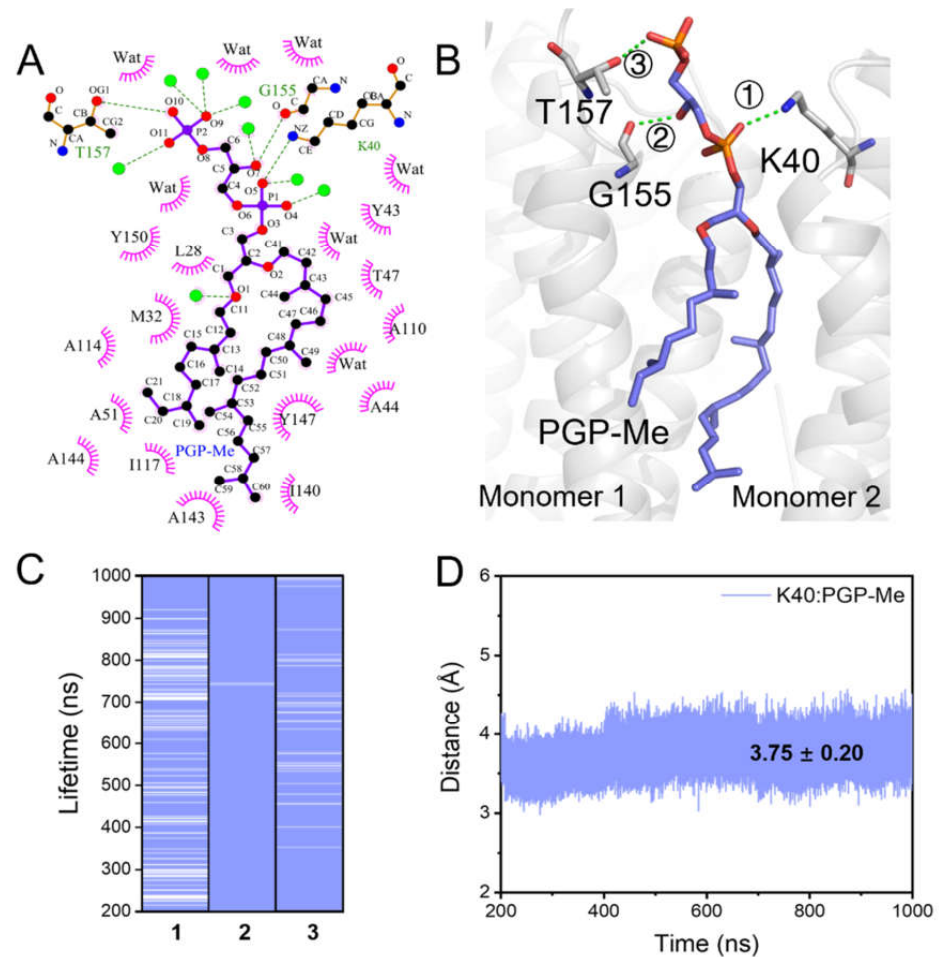
Figure 4. Schematic representation of PGP-Me binding to the bR trimer. ( A ) The LigPlot+ diagrams of the PGP-Me binding sites from the last snapshot of M1; the green dotted lines and the pink spoked arcs represent H-bond and hydrophobic interactions, respectively; ( B ) the possible H-bond interactions (green dotted line) between PGP-Me and the two adjacent monomers in the bR trimer. The grey sticks represent the residues interacting with PGP-Me via H-bond, and the dark-blue sticks represent PGP-Me; ( C ) evaluation of the lifetimes of the H-bond interactions for PGP-Me; see ( B ) for the description of the numbers: (1) K40∙∙∙O5 of the phosphate group; (2) G155∙∙∙O7 of the phosphate group; (3) T157∙∙∙O10 of the phosphate group; ( D ) the evolution of the distance between K129 and the galactosyl-3-sulfate of S-TGA-1. These interaction modes were reproducible in the second time-repeating simulation, as shown in Figures S3 and S4.